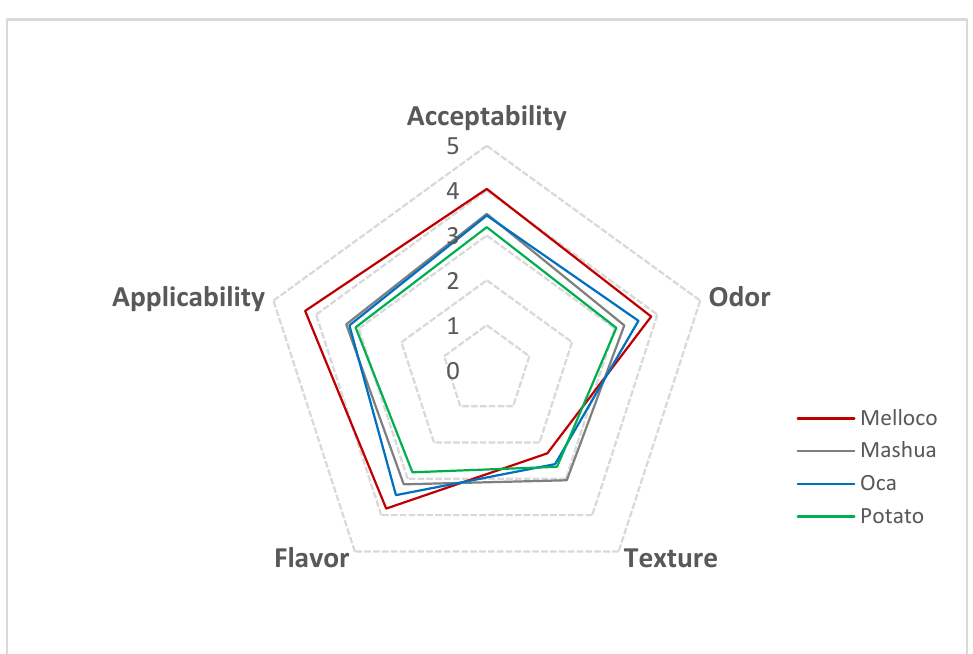
Figure 8. Sensorial evaluation of films extracted from each Andean tuber analyzed, blended with